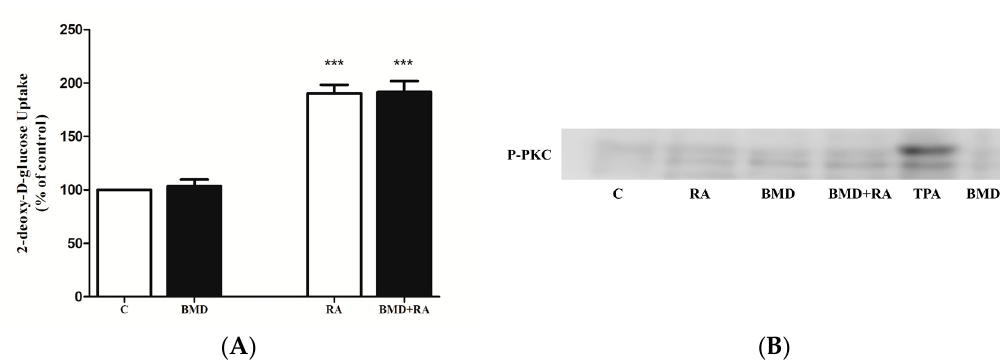
Figure 7. ( A ) Effect of bisindolylmaleimide I (BMD) on rosmarinic acid (RA)-induced glucose